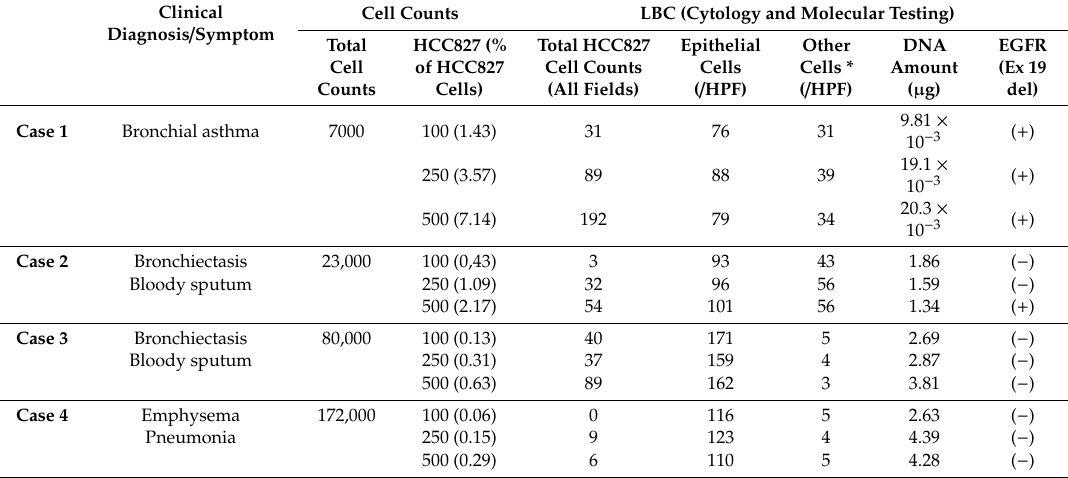
Table 2. Cell counts and EGFR mutation detection in the sputum (1).